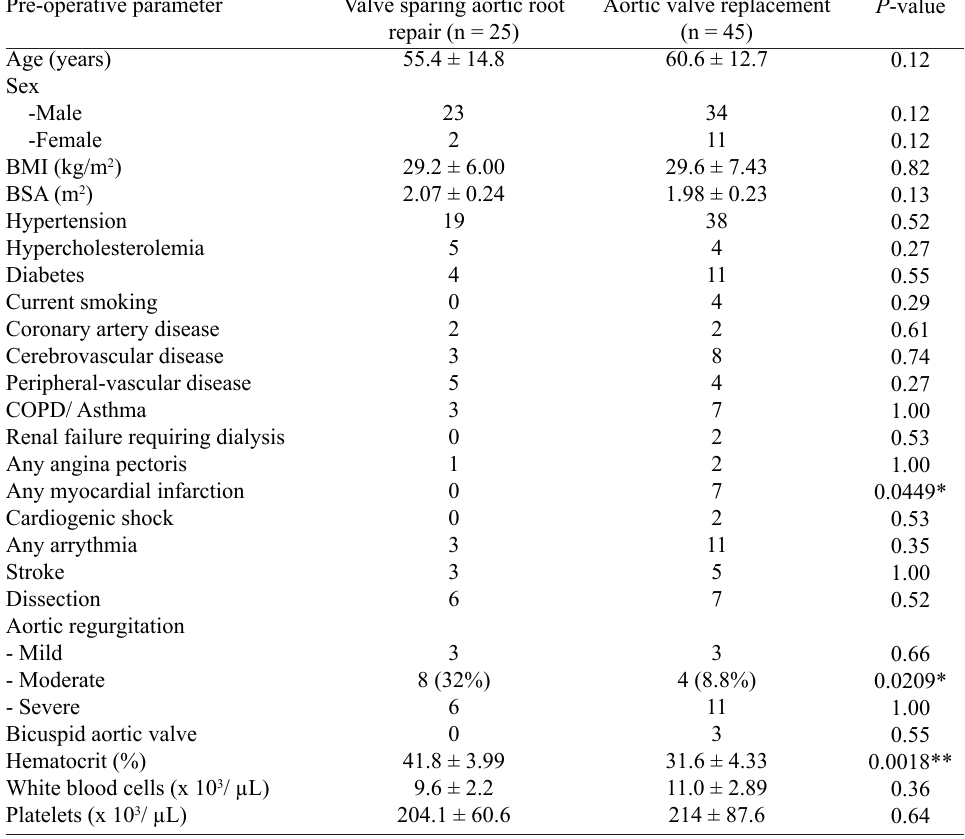
Table 1. Preoperative characteristics of both